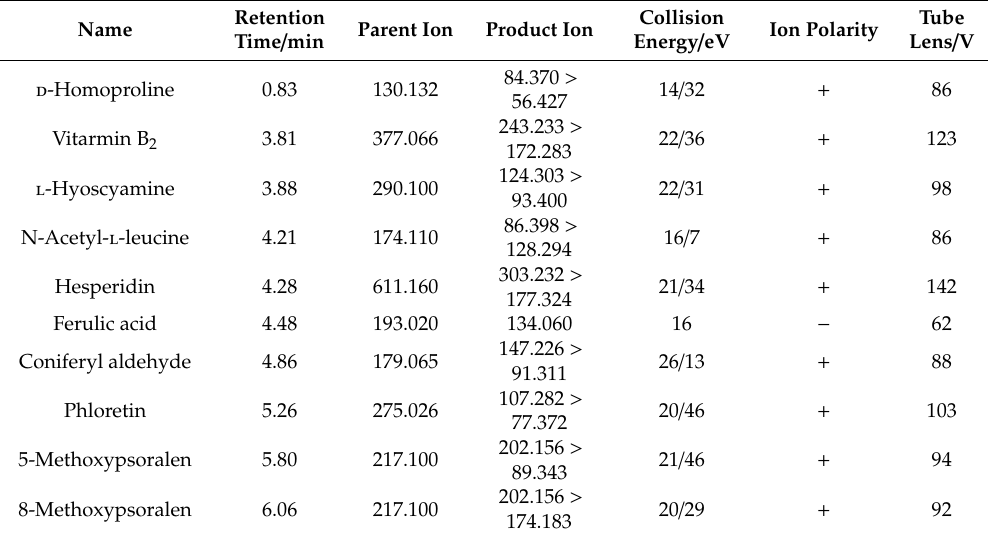
Table 1. Mass spectrometric parameters of target